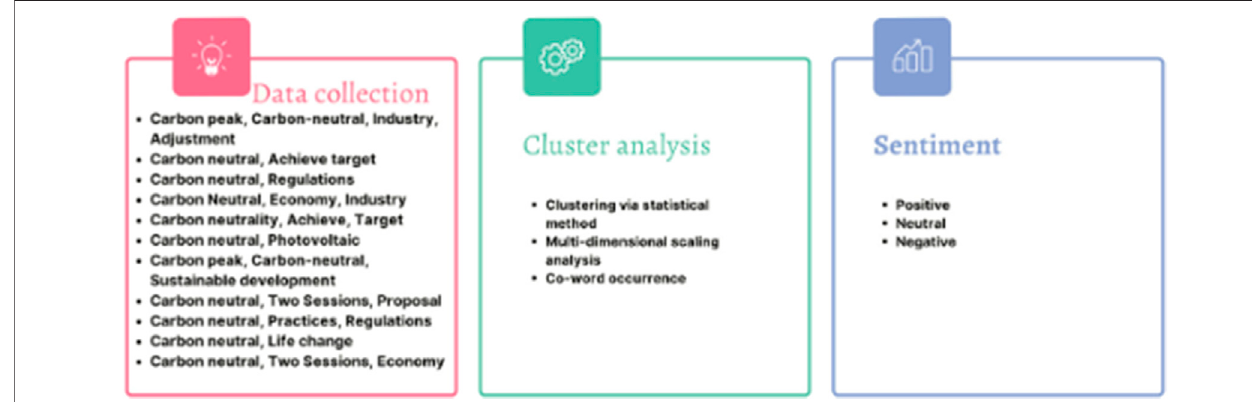
FIGURE 1 | Research fl ow chart.